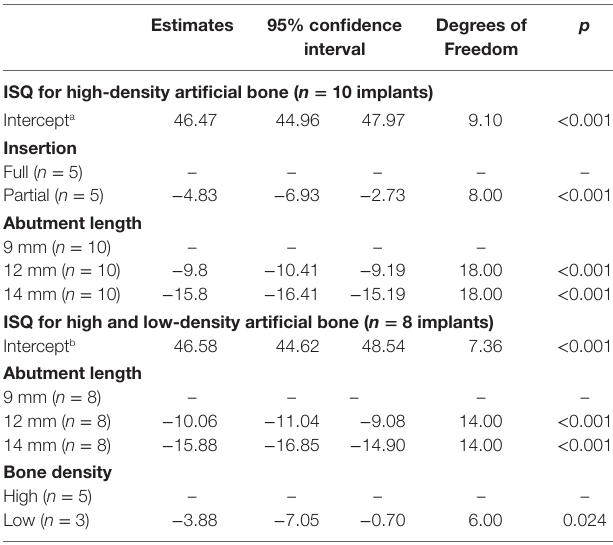
TABle 2 | Two mixed models for implant stability quotient (ISQ).